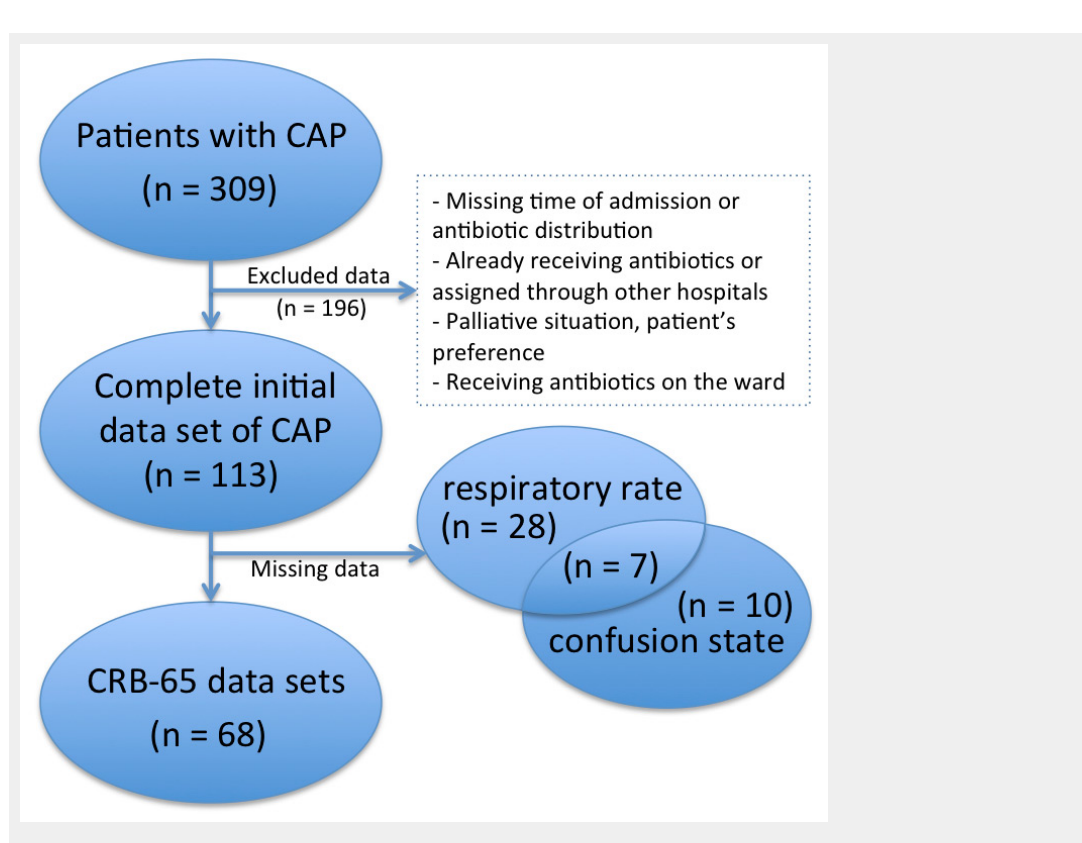
Figure 1 Flow chart of CRB-65 data set obtained from patients with community acquired pneumonia (CAP).